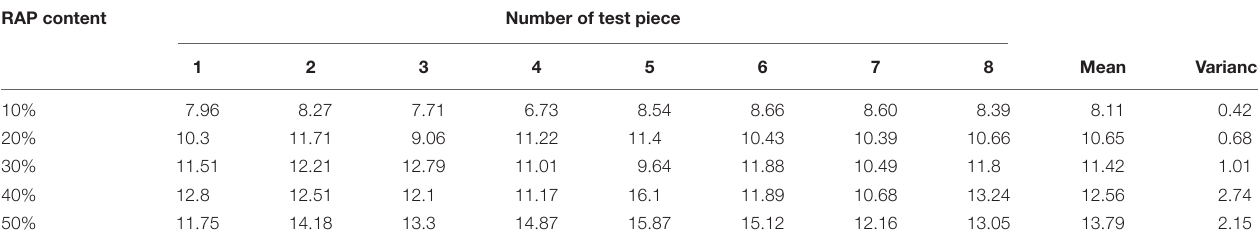
TABLE 5 | Results of the stability test.